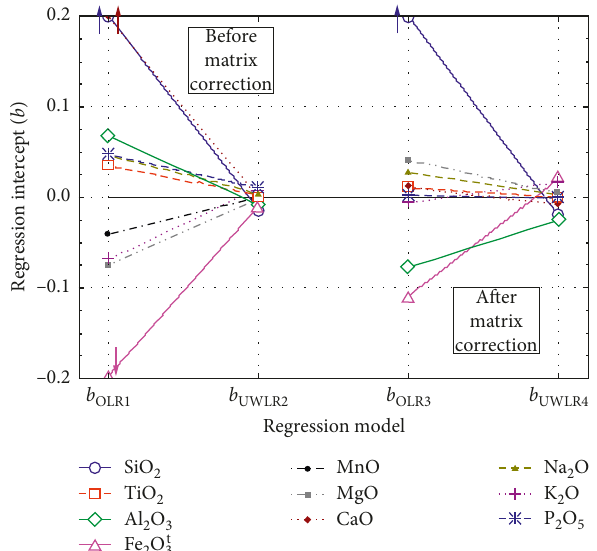
Figure 2: Intercept ( b ) values for the ordinary least-squares linear regression (OLR) and uncertainty-based weighted least-squares linear regression (UWLR) models for the XRF calibration of major elements (SiO 2 to P 2 O 5 ) in rocks and minerals. Symbols are shown as inset. For abbreviations, see Figure 1. Note some intercept values plotted outside the graph; this is indicated by arrows next to the data point. The horizontal line at the intercept value of zero represents the “ideal”